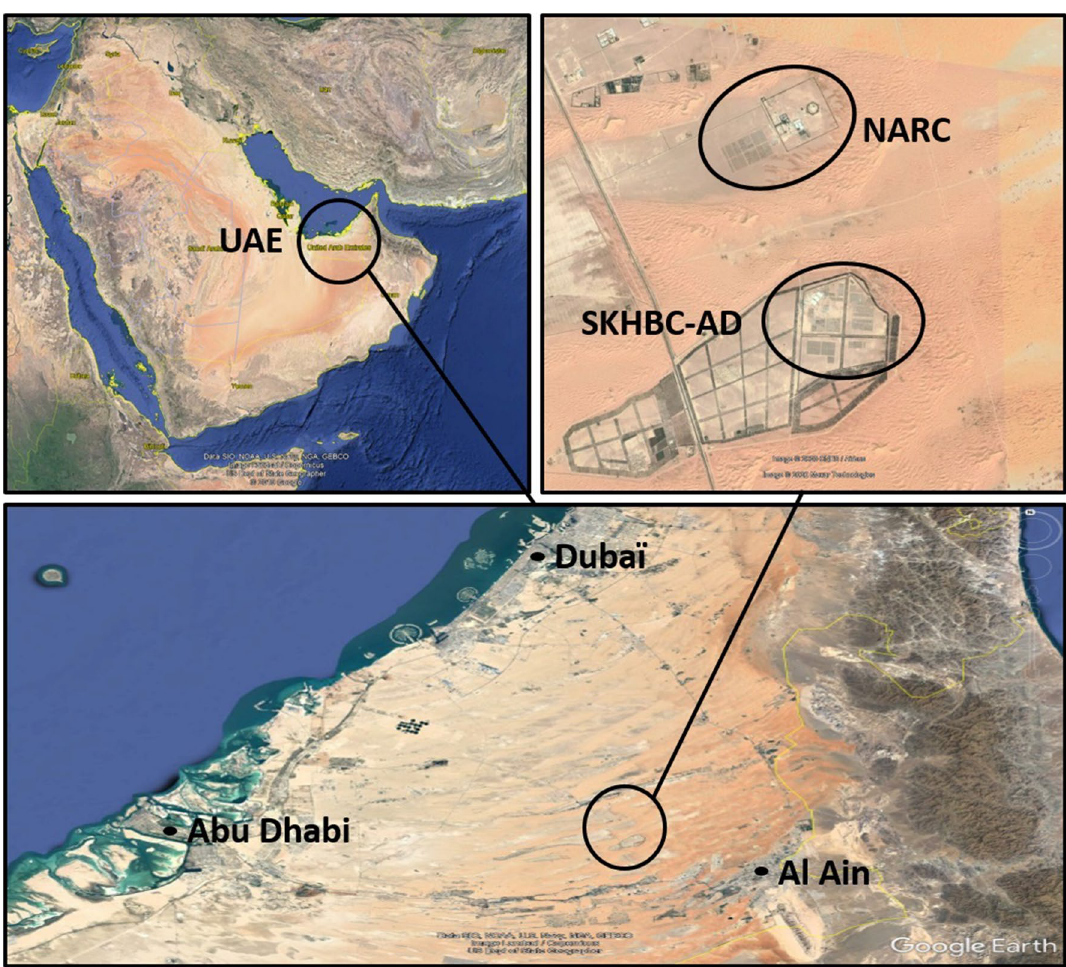
Figure 1. Satellite view of the United Arab Emirates. At the bottom right, the breeding sites of the National Avian Research Center (NARC) and the Sheikh Khalifa Houbara Breeding Center—Abu Dhabi (SKHBC-AD). This figure was produced on the basis of satellite views from Google Earth (Data SIO, NOAA, U.S. Navy, NGA, GEBCO, Image Landsat/Copernicus, US Dept of State Geographer @ 2019 Google, Image @ 2020 CNES/ Airbus, Image @ 2020 Maxar